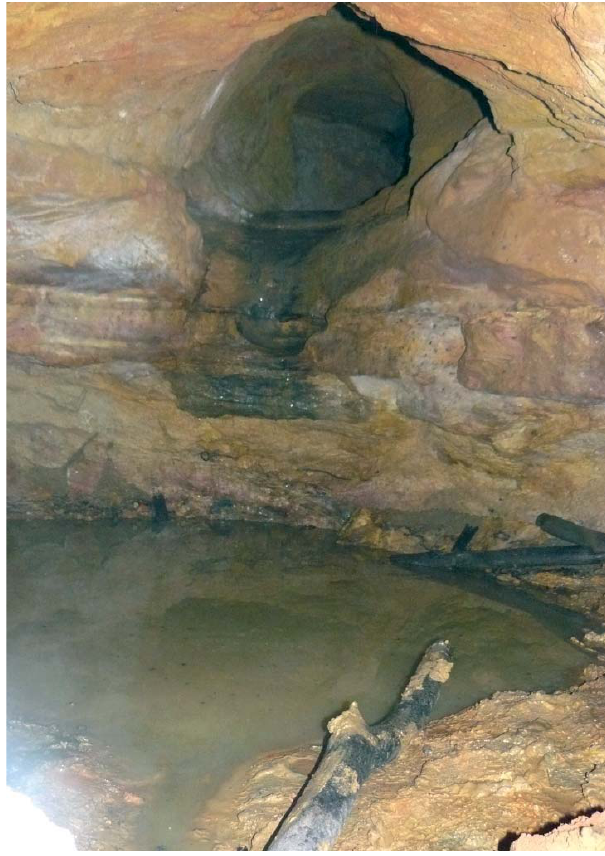
Fig. 9. Inside Cueva El Misterio, upper Sogamoso River ba- sin, Santander, Colombia. Type-locality of Trichomycterus uisae.